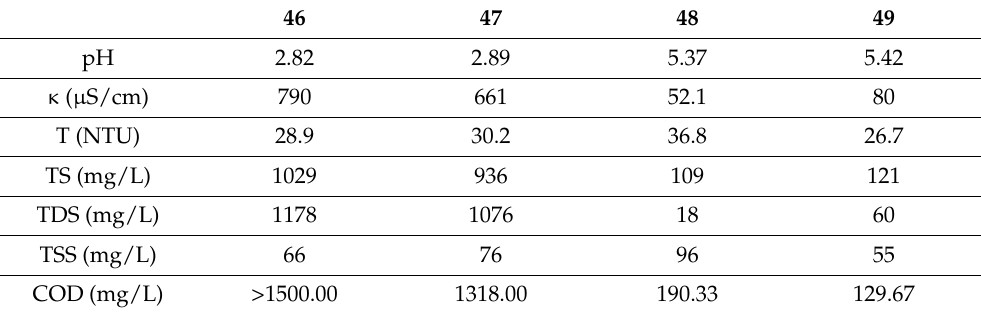
Table 5. Characteristics of washing effluents.